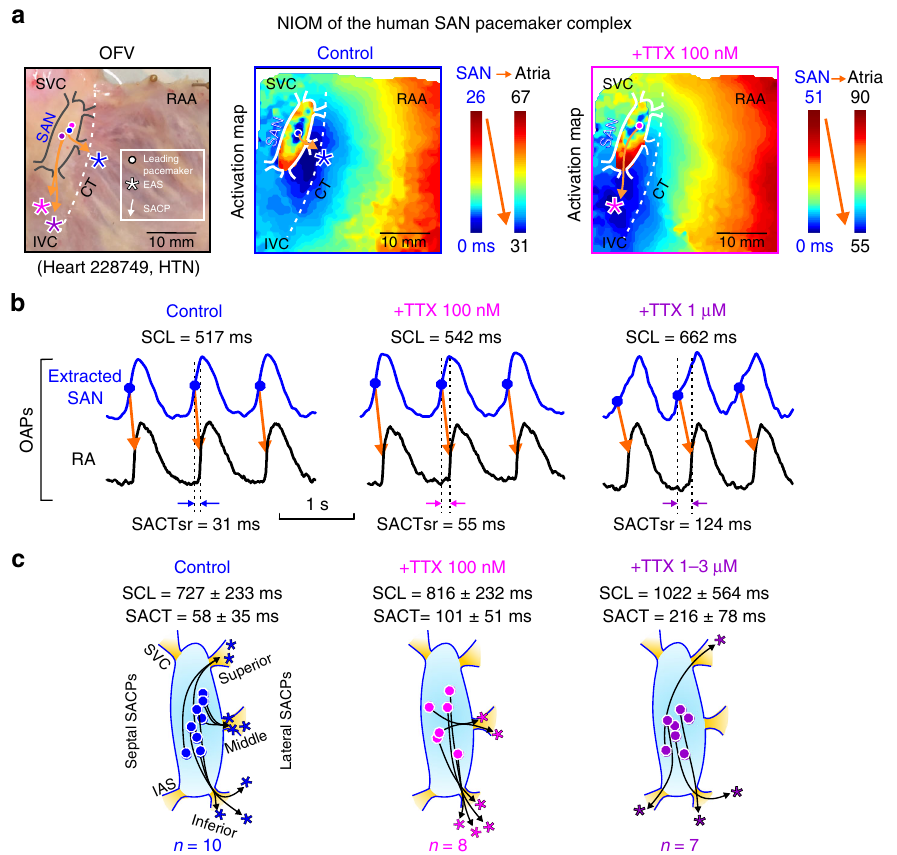
Fig. 1 High-resolution near-infrared optical mapping (NIOM) reveals effect of nNav and cNav blockade on human SAN intramural activation. a Left: human SAN preparation and optical mapping fi eld of view (OFV). Activation maps of Heart 228749 at control (middle) and during 100 nM TTX perfusion (right). Dot indicates the leading pacemaker inside the sinoatrial node (SAN); asterisk indicates the earliest atrial activation site (EAS); arrow indicates the sinoatrial conduction pathway (SACP). b TTX effects on sinus cycle length (SCL) and sinoatrial conduction time at sinus rhythm (SACTsr). c Locations of SAN leading pacemaker (dots), earliest atrial activation site, and sinoatrial conduction pathways at control (left, n = 10), during perfusion of 100 nM (middle, n = 8), and 1 – 3 µ M TTX (right, n = 7). Data presented as mean ± SD. CT crista terminalis, n/cNav neuronal/cardiac sodium channels, OAP optical action potential, RA (A) right atrial (appendage), S/IVC superior/inferior vena cava, TTX tetrodotoxin. Source data are provided as a Source Data fi le.